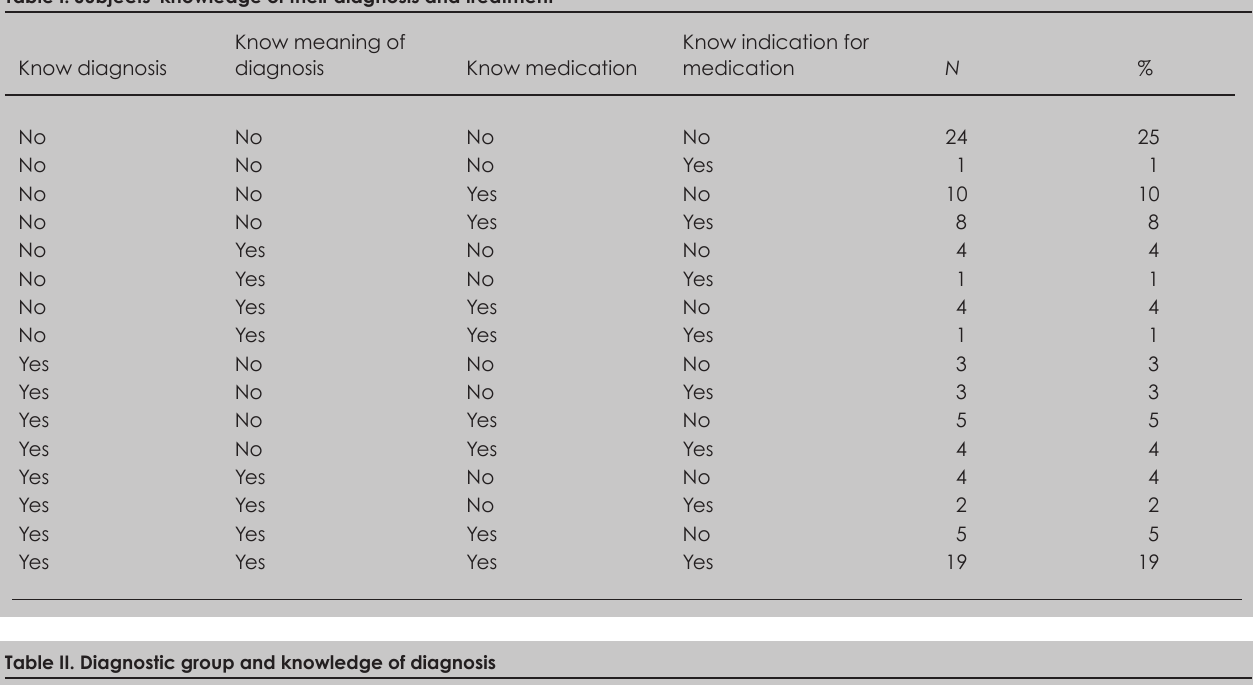
Table I. Subjects' knowledge of their diagnosis and treatment